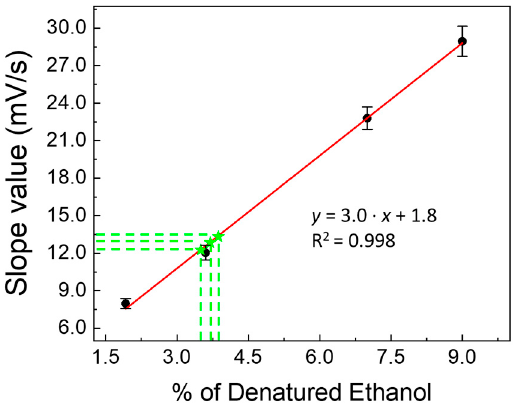
Figure 11. Calibration curves used for ethanol determination in samples of disinfectant solution for COVID-19. Calibration curve obtained by «kinetic methods» (slope values vs. increasing percentage of denatured ethanol), using the fuel cell modified by LDHs (63 mg) and H 2 O 2 (12 mmol L − 1 ) in solution in denatured ethanol solutions tested. Green stars represent found percentage values of ethanol in disinfectant samples.